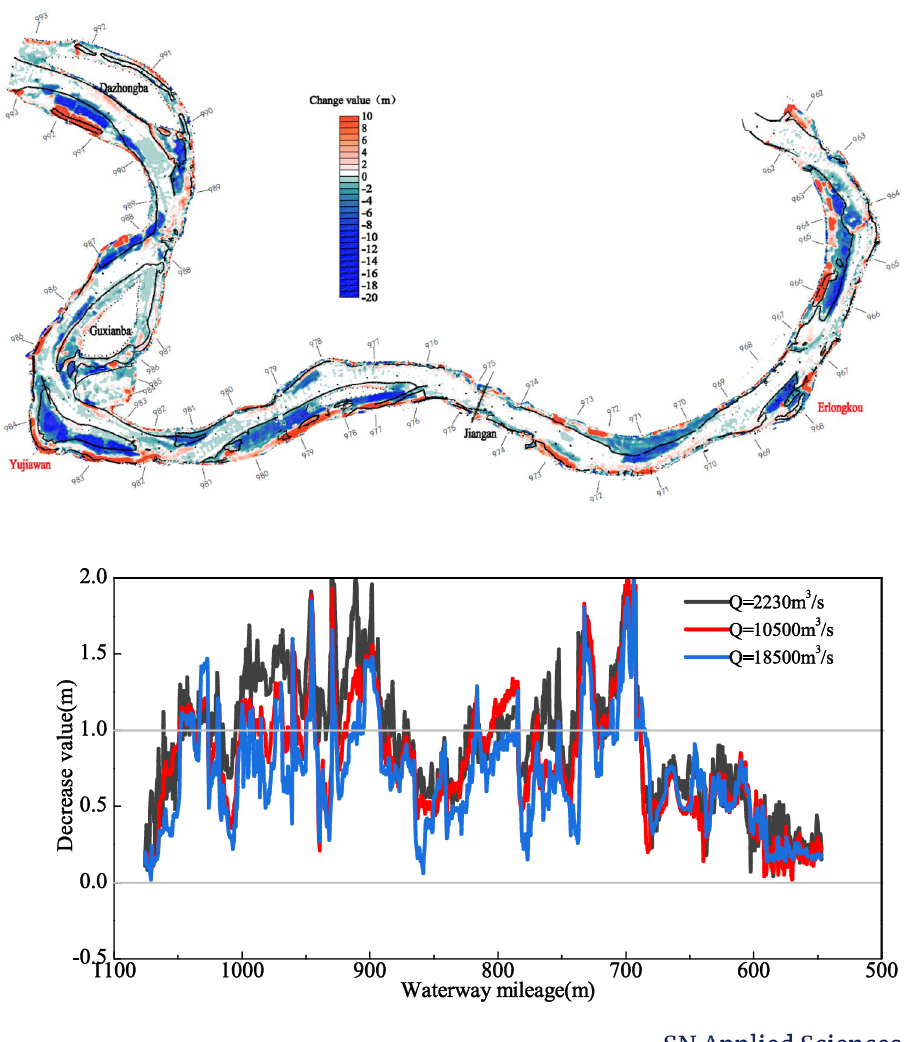
Fig. 20 Sand mining area plane distribution map (Erlongkou-Xianglutan) (Posi- tive values represent sedimen- tation along the river section, and negative values represent erosion and sand mining.)